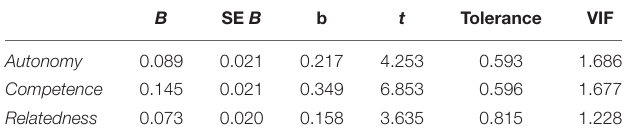
TABLE 6 | Regression coefficients and collinearity statistics when Autonomy , Competence , and Relatedness from the reduced scale are regressed against psychological well-being